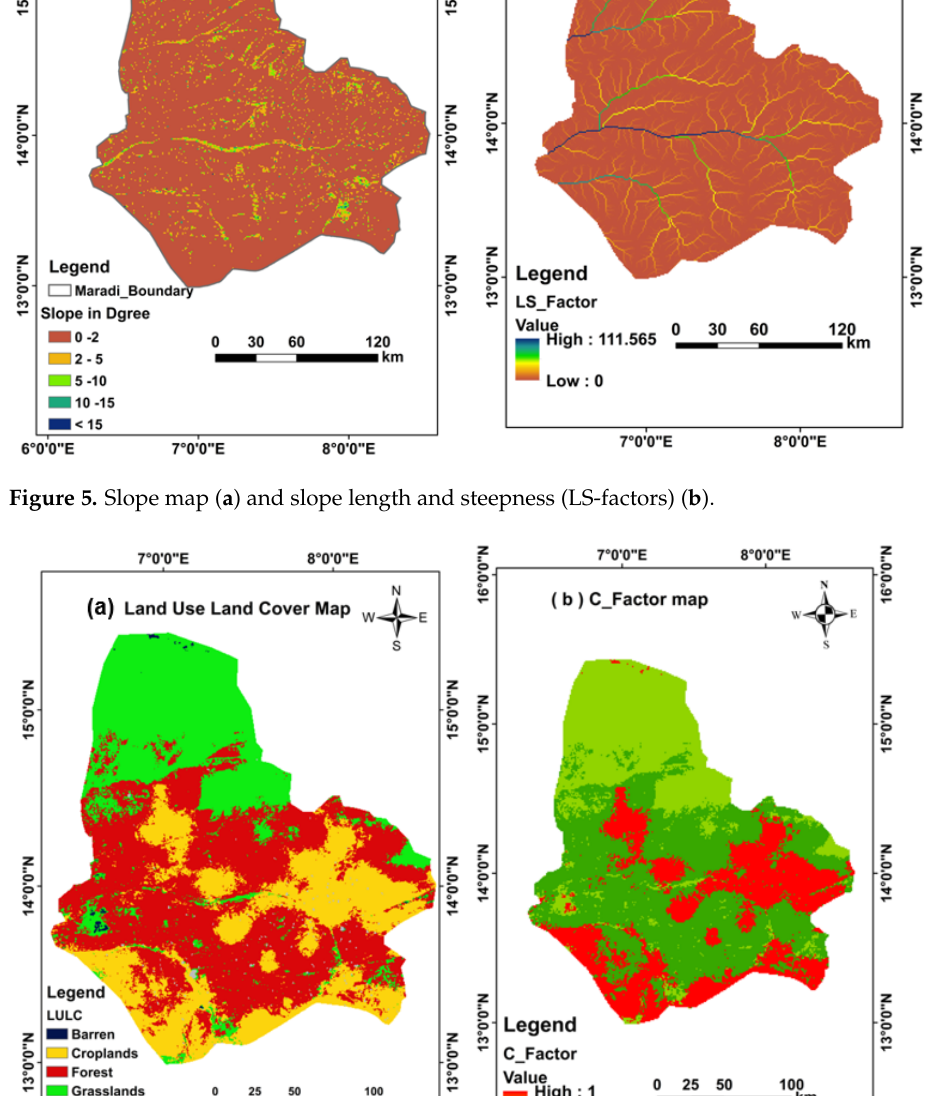
upper and outer parts of the